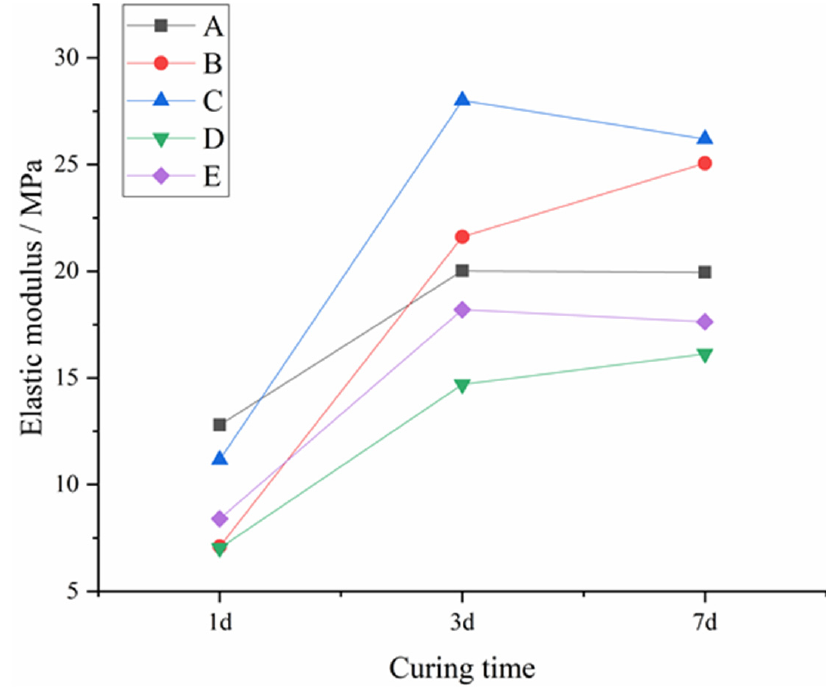
Figure 4. The elastic modulus of the specimen at different curing times.